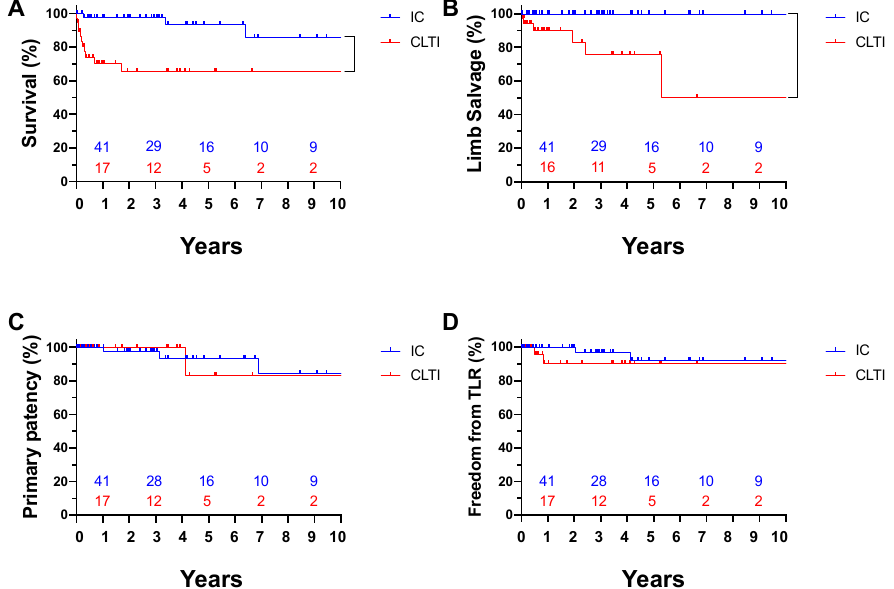
Figure 3. Ten-year outcomes after femoral endarterectomy, according to initial limb status. ( A ) Sur- vival, p = 0.0010; ( B ) limb salvage, p = 0.0002; ( C ) primary patency, p = 0.8992; ( D ) freedom from target lesion revascularization, p = 0.3182. IC, intermittent claudication; CLTI, chronic limb-threat- ening ischemia. Numbers at risk are shown above the x-axis.